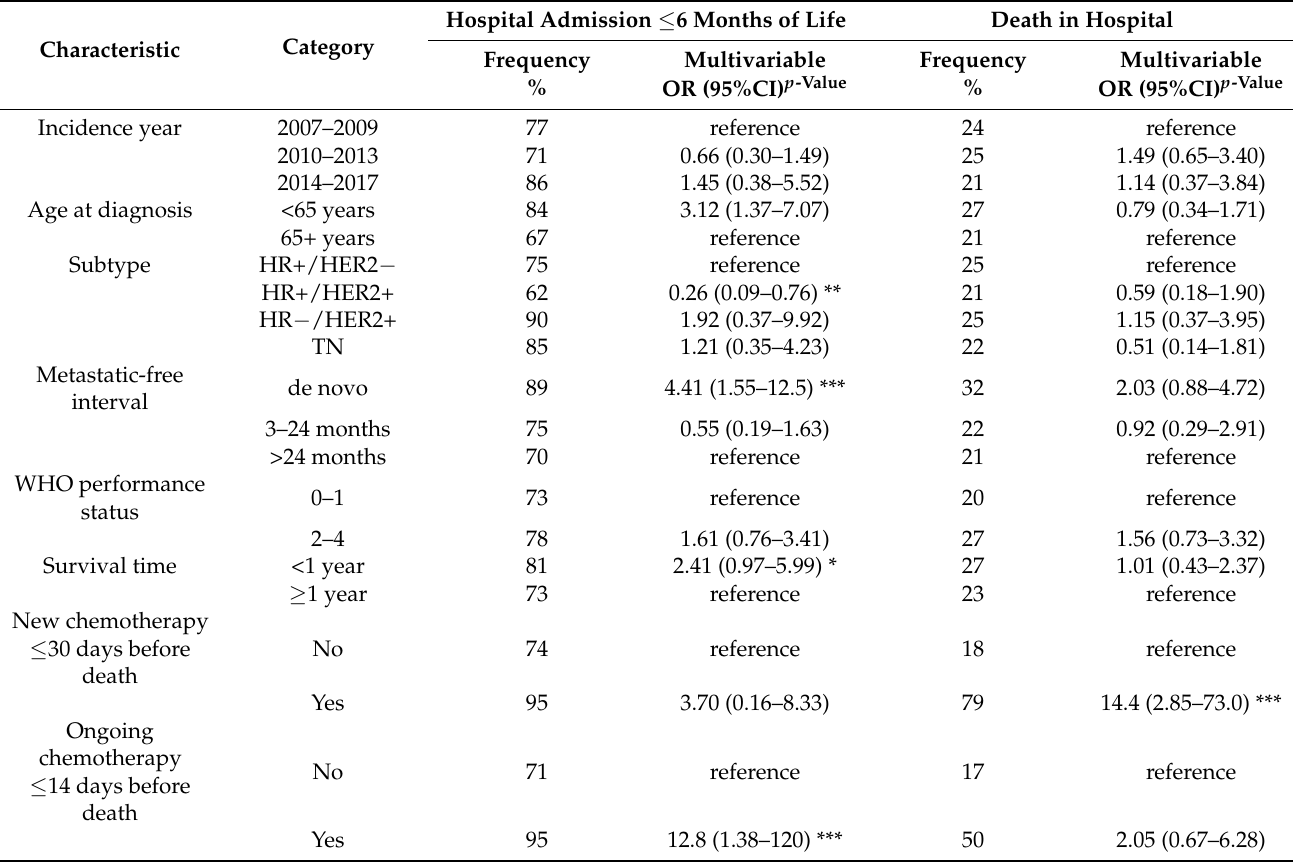
Table 3. Characteristics associated with hospital admission and death in the hospital in the last six months of life, n = 200 # .